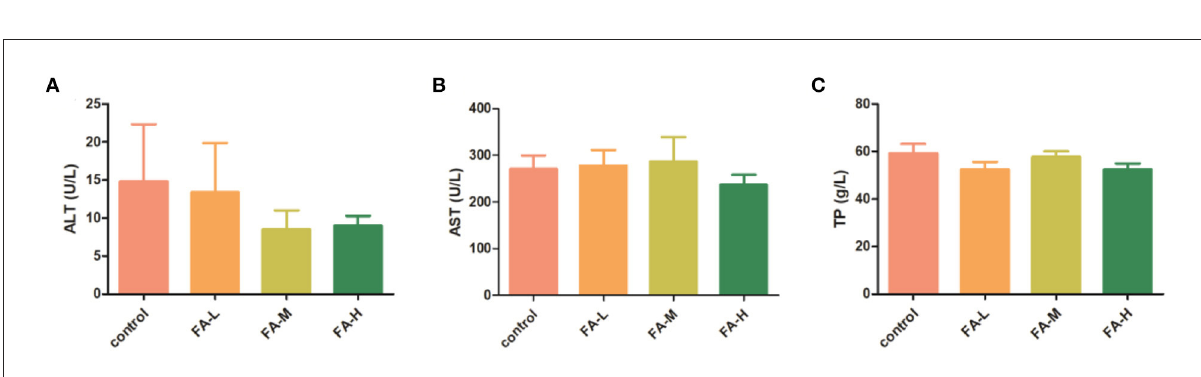
FIGURE2 Effect of FA on serum ALT (A) , AST (B) , and TP (C)